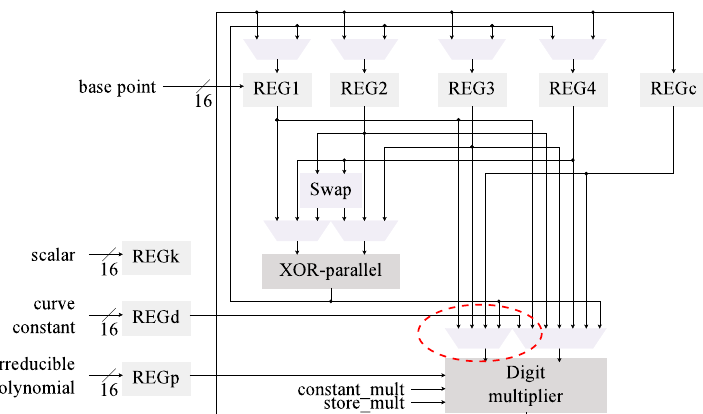
Figure 3. Architecture C2 for kP , Wang inversion and a digit-multiplier are